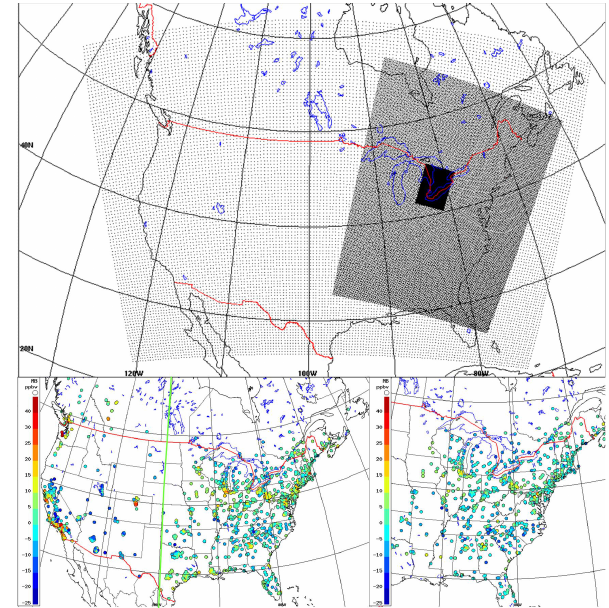
Fig. 2. (a) AURAMS 42-km, 15-km, and 2.5-km domains, (b) mon- itoring stations used for 42km comparison to observations (Mean Bias shown; region east of 100 ◦ W is “42-km-East”); (c) monitor- ing sites used for 15-km comparison to observations (Mean Bias